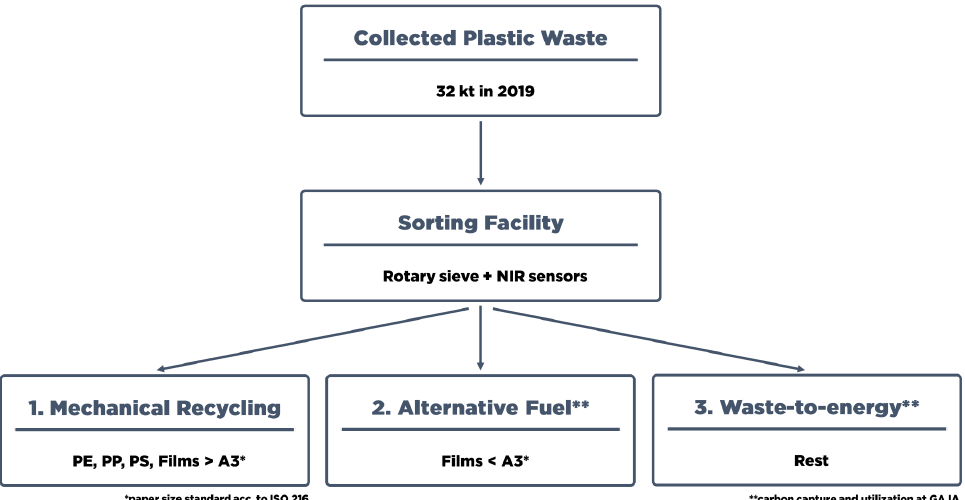
Figure 3. Proposed comprehensive waste treatment and recycling